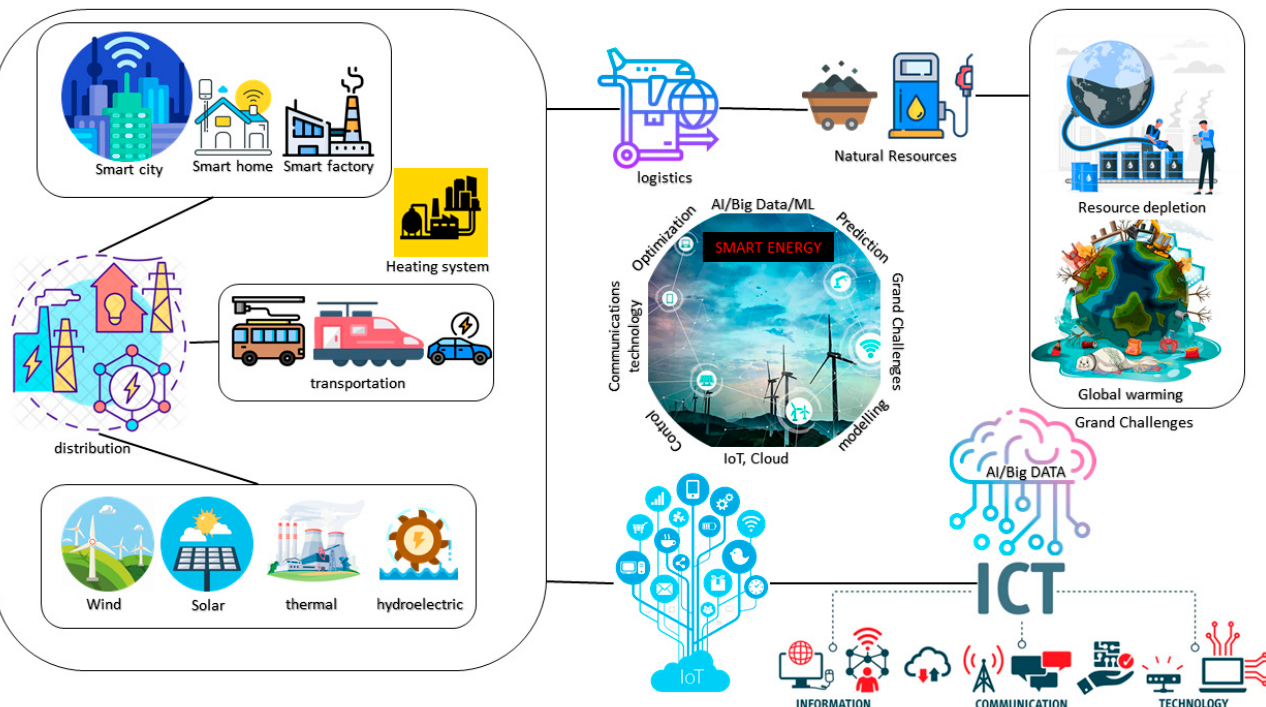
Figure 1. Smart energy concept. Generation, distribution, and consumption scenarios are boxed. IoT is used to sense and control the different components of the system. ICT and AI are used to control the overall system to meet grand challenges (free icon art is used for illustration).